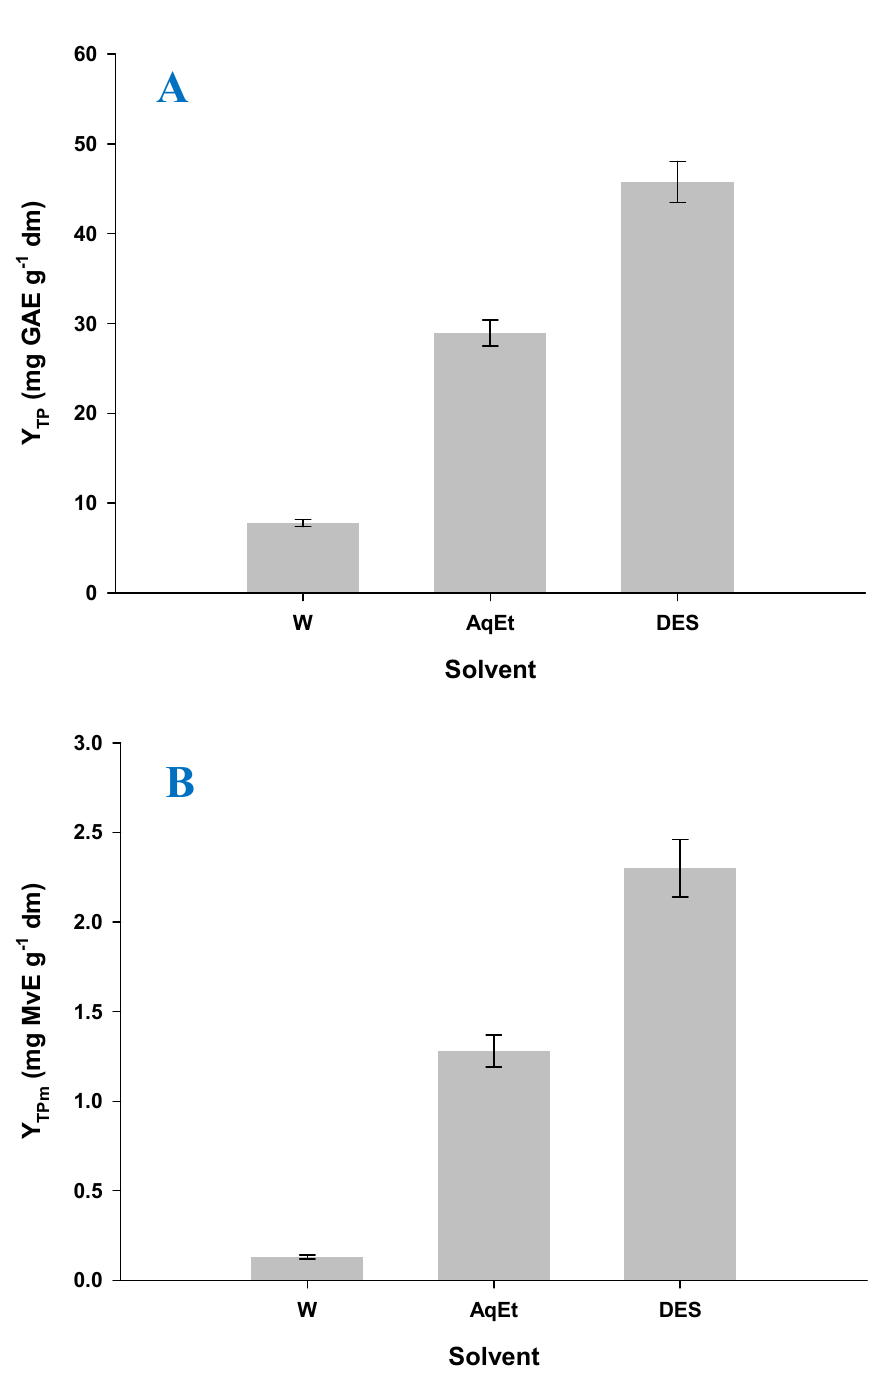
Figure 7. Plot illustrating the Y TP ( A ) and Y TPm ( B ) achieved with GL-SBz compared to 60% aqueous ethanol and water. Samples were pretreated with ultrasonication for 15 min, with a P = 104.33 W at room temperature (25 ± 2 °C). After pretreatment, batch stirred-tank extractions were performed under optimized conditions ( t = 240 min, T = 80 °C), at R L/S = 10 mL g − 1 and 500 rpm. However, it should be noted that the range of polyphenol yields from RGP extraction may vary largely from 7.70 mg GAE g − 1 dm [32] to as high as 77.80 mg GAE g − 1 dm [33]. Similarly, the Y TPm attained with GL-SBz was 1669% and 80% higher compared to that of water and aqueous ethanol, respectively (Figure 7B). The level of 2.30 mg MvE g − 1 dm achieved for Y TPm using GL-SBz was higher than levels acquired with conventional sol- vents, such as 50% methanol [34], 57% ethanol [35] and water [36], but higher values